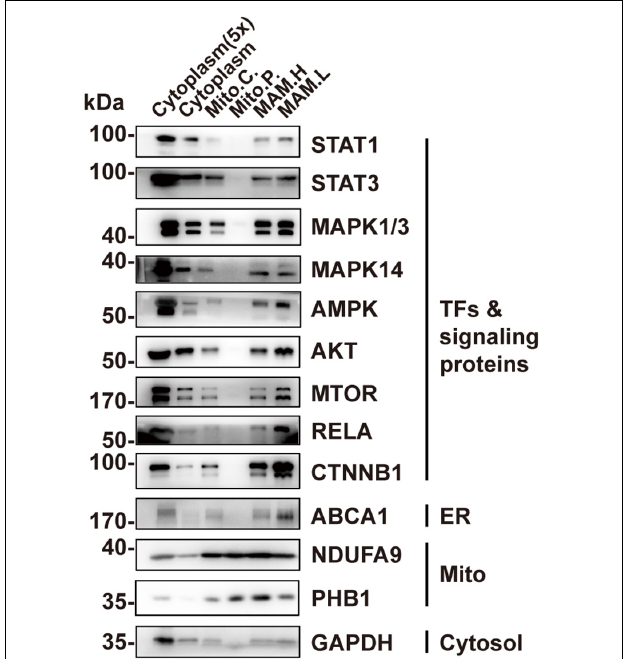
FIGURE 4 | Other TFs or signaling proteins are present in MAM but not in mitochondria. Western blot analysis of the Percoll density centrifugation fractions from brain showed that transcription factors including STAT1, MAPKs, AMPK, AKT, mTOR, and RELA could only be found in the MAM fractions but not in pure mitochondria. Mito.C., crude mitochondrial fraction; Mito.P., pure mitochondrial fraction; MAM.H, heavy MAM; MAM.L, light